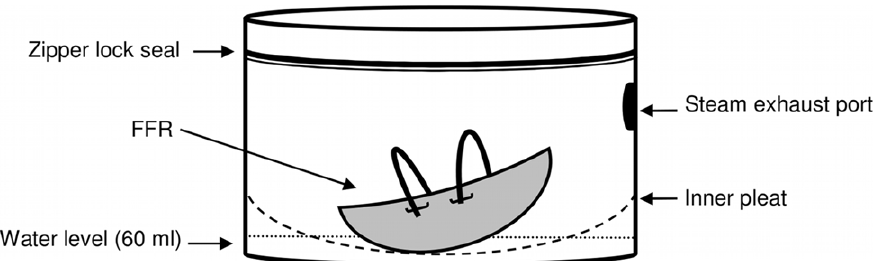
Figure 2. Illustration of the components of the microwave steam bags and the placement of a typical FFR into the water reservoir.